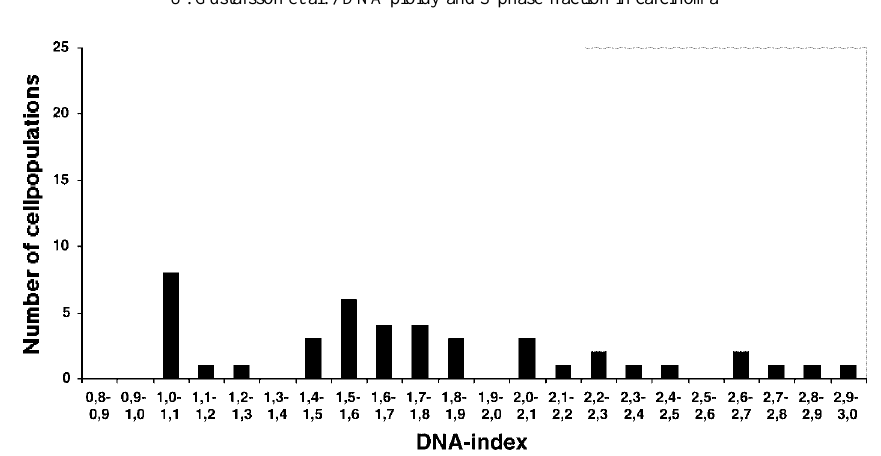
Fig. 3. Distribution of DNA-indices in 43 cellpopulations from 26 patients with gallbladder cancer of advanced local tumour stage (T3–T4). tases. Among the 31 cellpopulations from 13